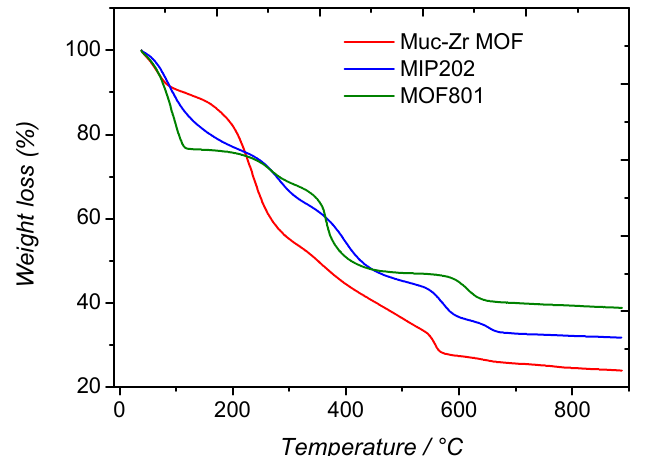
Figure 4. Thermograms of MOFs: (green) MOF-801, (blue) MIP-202, and (red) Muc-Zr MOF.